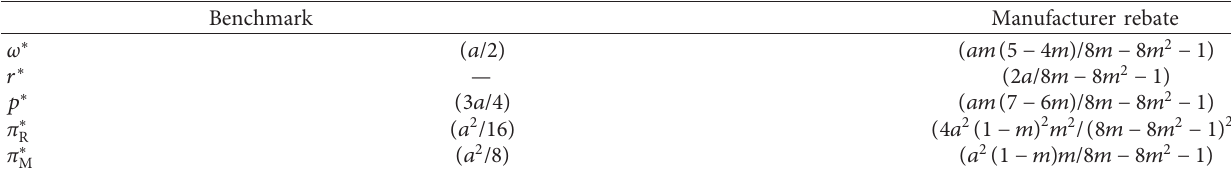
Table 1: Equilibrium results in the monopoly supply chain